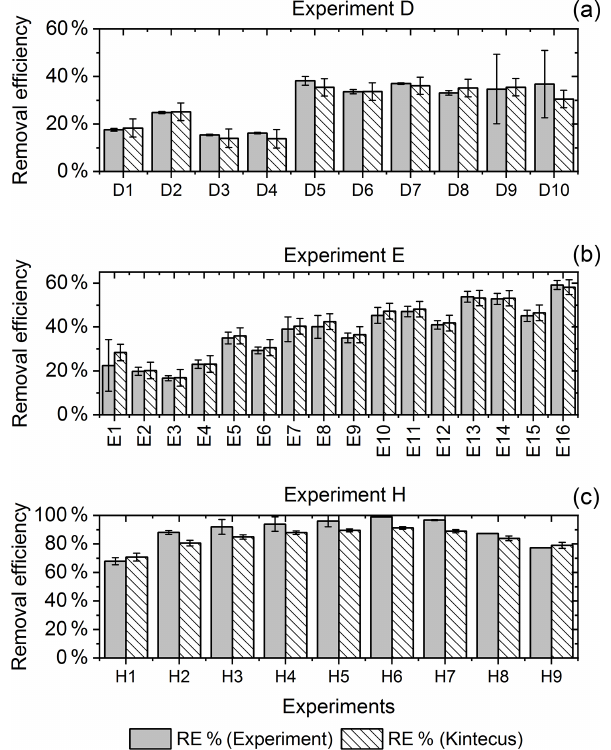
for the single-tube system. 2